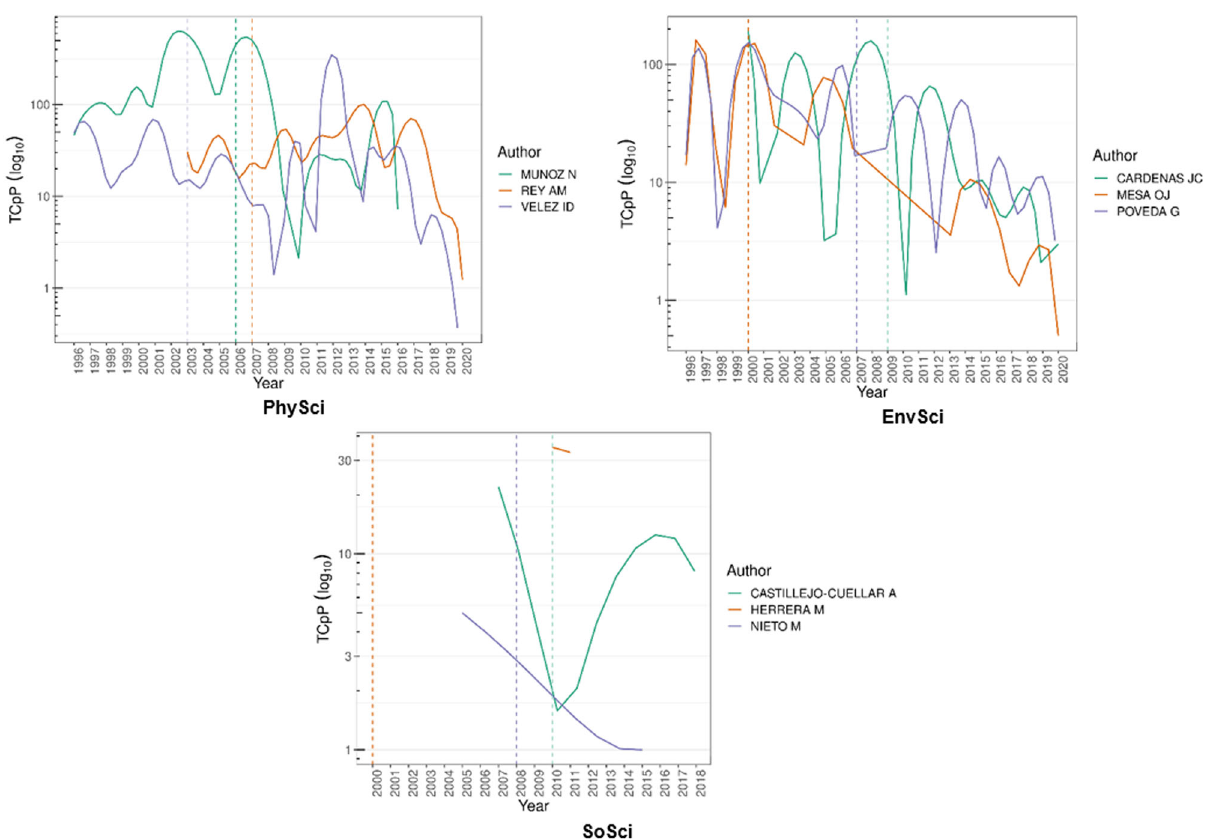
Fig. 5 Citations per article by category of top-three most cited researchers for CSE. Source: the authors based on AAEF (Fundación Alejandro Ángel Escobar, 2007, 2020) and Scopus (2020b). Note: the dashed line points to the year each researcher was awarded the AAEP special mention; TCpP: citations per